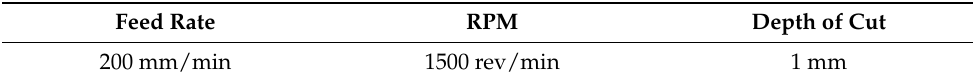
Figure 6. Visual description of experiment group showing all six cases with work-pieces represented by blue boxes and tooltips and their categorization by white boxes. Table 1. Turning operation parameters.